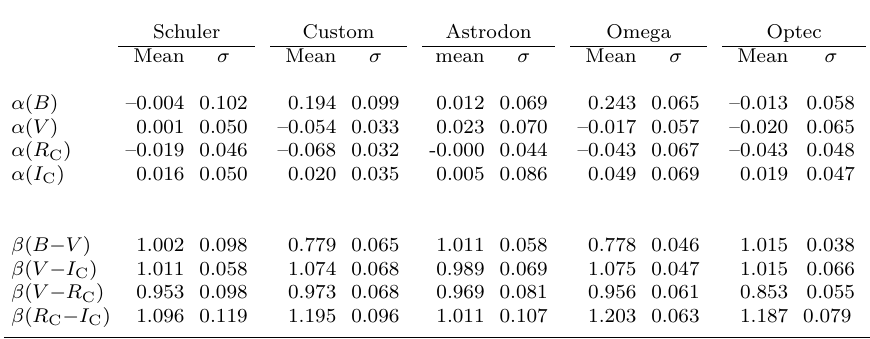
Table 1. Mean values and dispersions for the distributions in Figure 3. Schuler Custom Astrodon Omega Optec Mean (cid:27) Mean (cid:27) mean